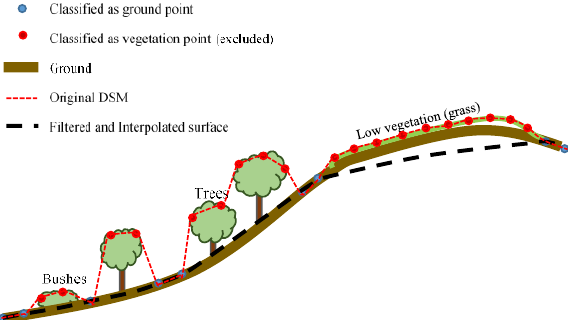
Figure 2: Proposed methodology - interpolation principle (among high trees and across grass